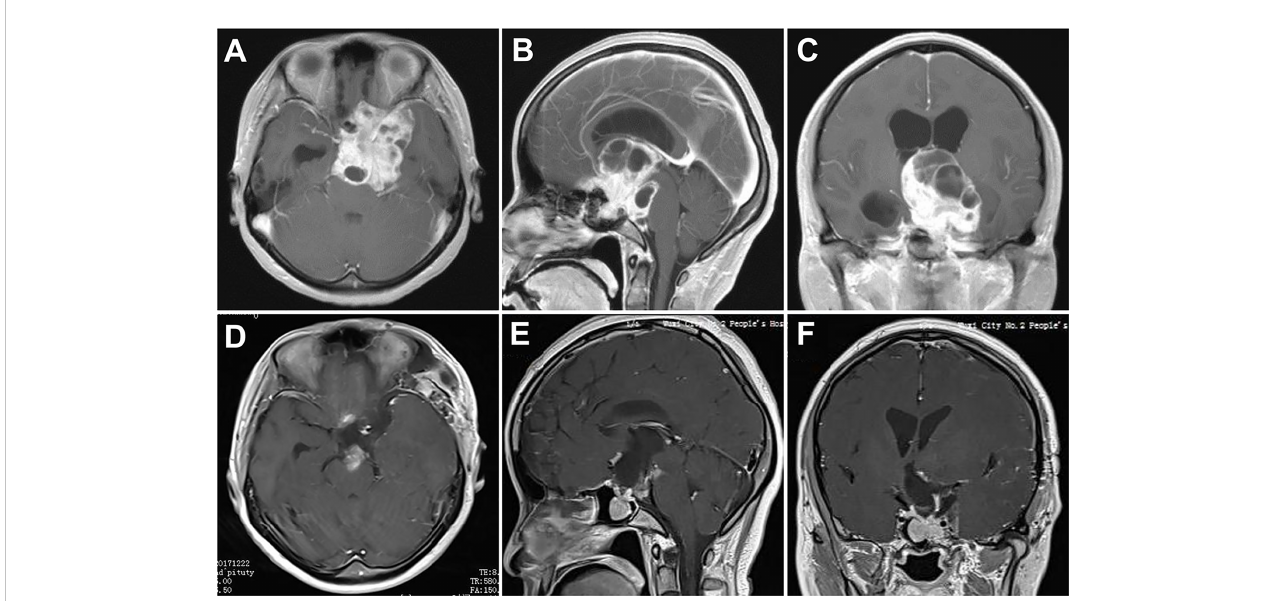
FIGURE 4 Case 3. Pre- and postoperative imaging fi ndings. (A – C) Preoperative axial (A) , sagittal (B) and coronal (C) gadolinium-enhanced T1-weighted MRI images showing a giant pituitary adenoma with extensive suprasellar extension. The tumor fi lls the entire third ventricle and invades into the sphenoid sinus. (D –